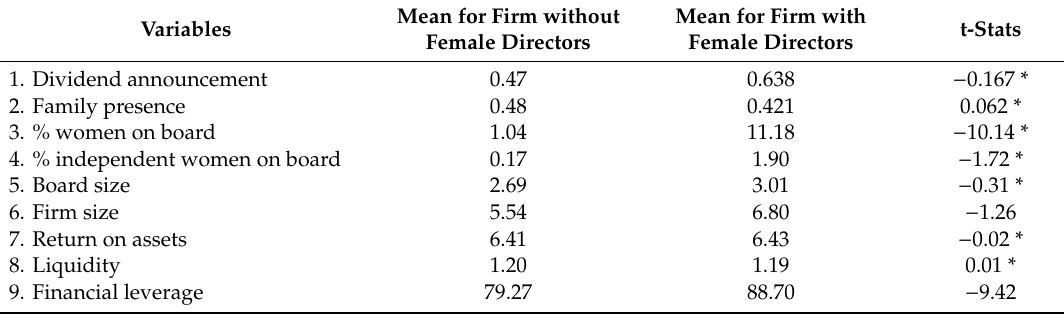
Table 5. Comparison of firms with and without female directors in Asian emerging economies.